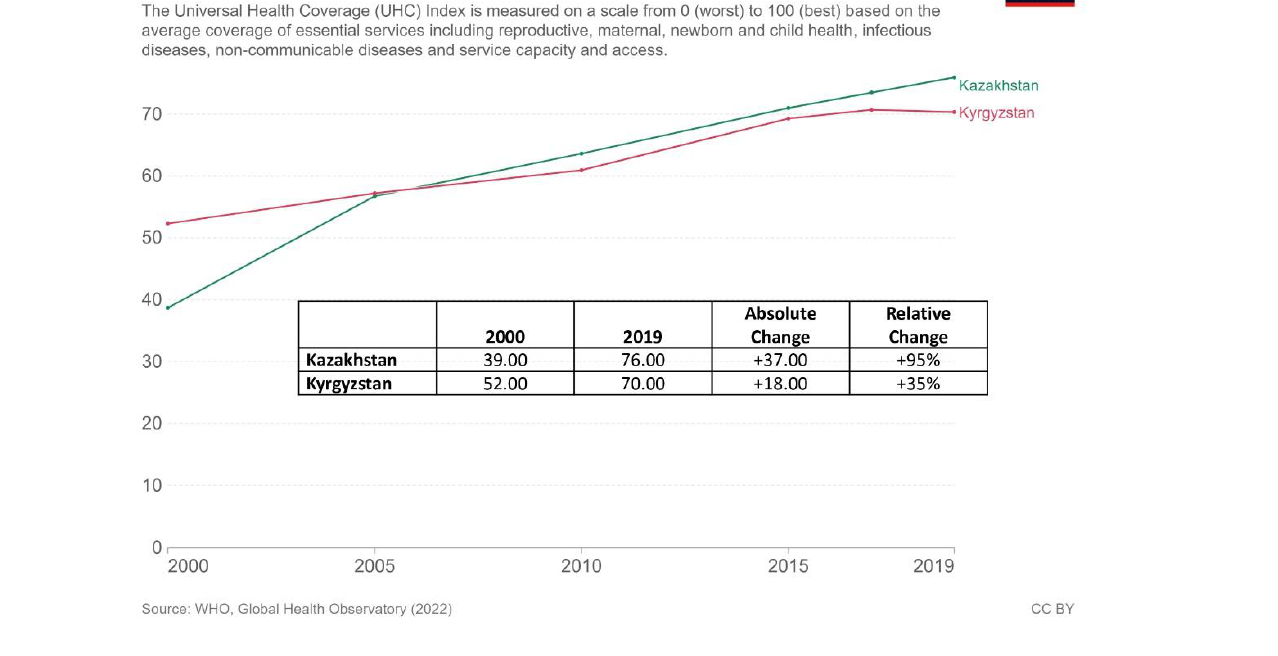
Figure 1. Dynamics of the universal health coverage index in Kazakhstan and Kyrgyzstan from 2000 to 2019 years. (Source: https://ourworldindata.org/grapher/universal-health-coverage- index?tab=chart&time=earliest..2019&country=KAZ~KGZ, Accessed August 15,